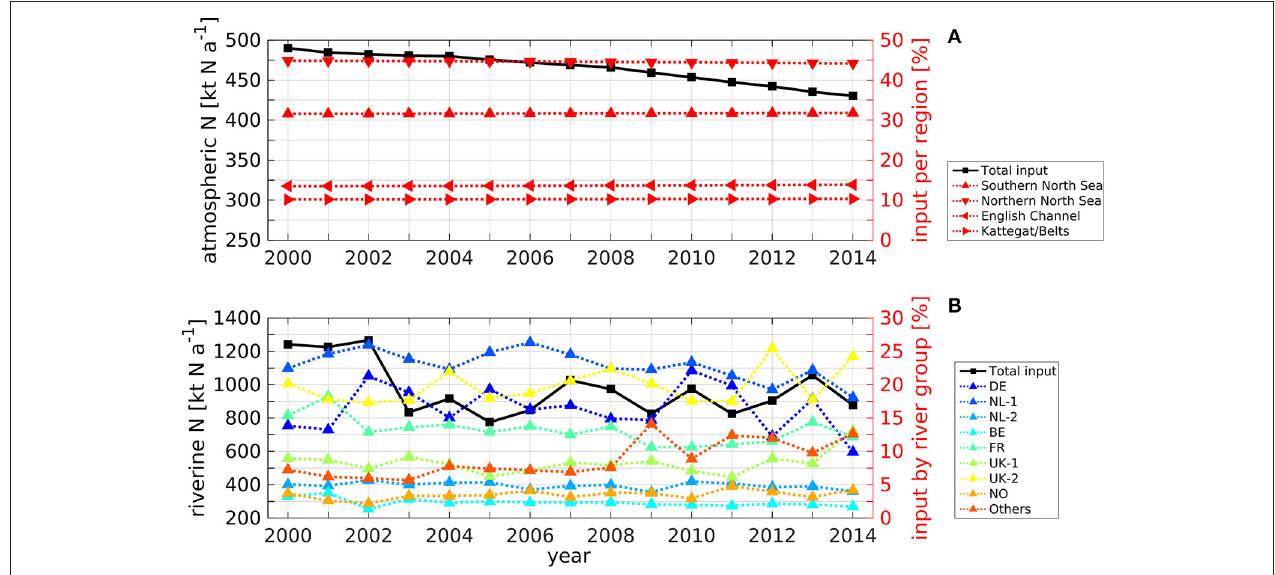
FIGURE 3 | Time series of annual (A) atmospheric and (B) riverine TN input (left y axes and solid lines) into the TBNT domain (see Figure 2 ). Relative contributions (right y axes and dotted lines) represent the contribution to the total input into the TBNT domain by different regions in case of atmospheric deposition and by different river groups (see Table 1 ) in case of riverine